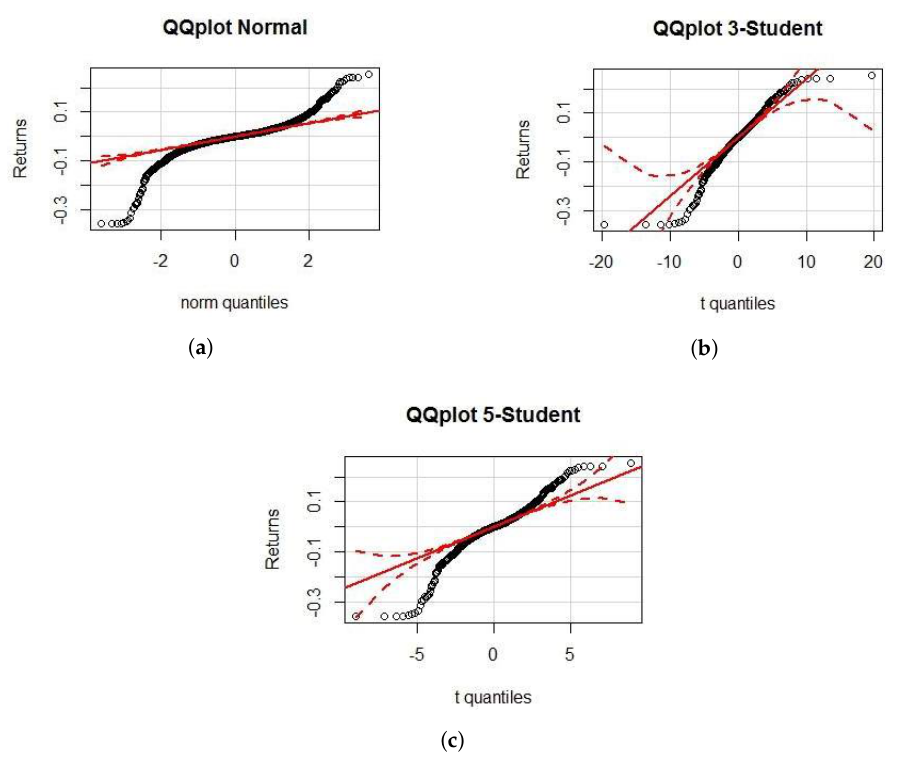
Figure 7. QQ plot for Normal and Student-t distributions. ( a ) QQ plot Normal; ( b ) QQ plot 3-Student; ( c ) QQ plot 5-Student. Table 1. Backtest results with and without low price effect (lpe) being taken into account. VR without lpe VR with lpe VaR vol without lpe VaR vol with lpe